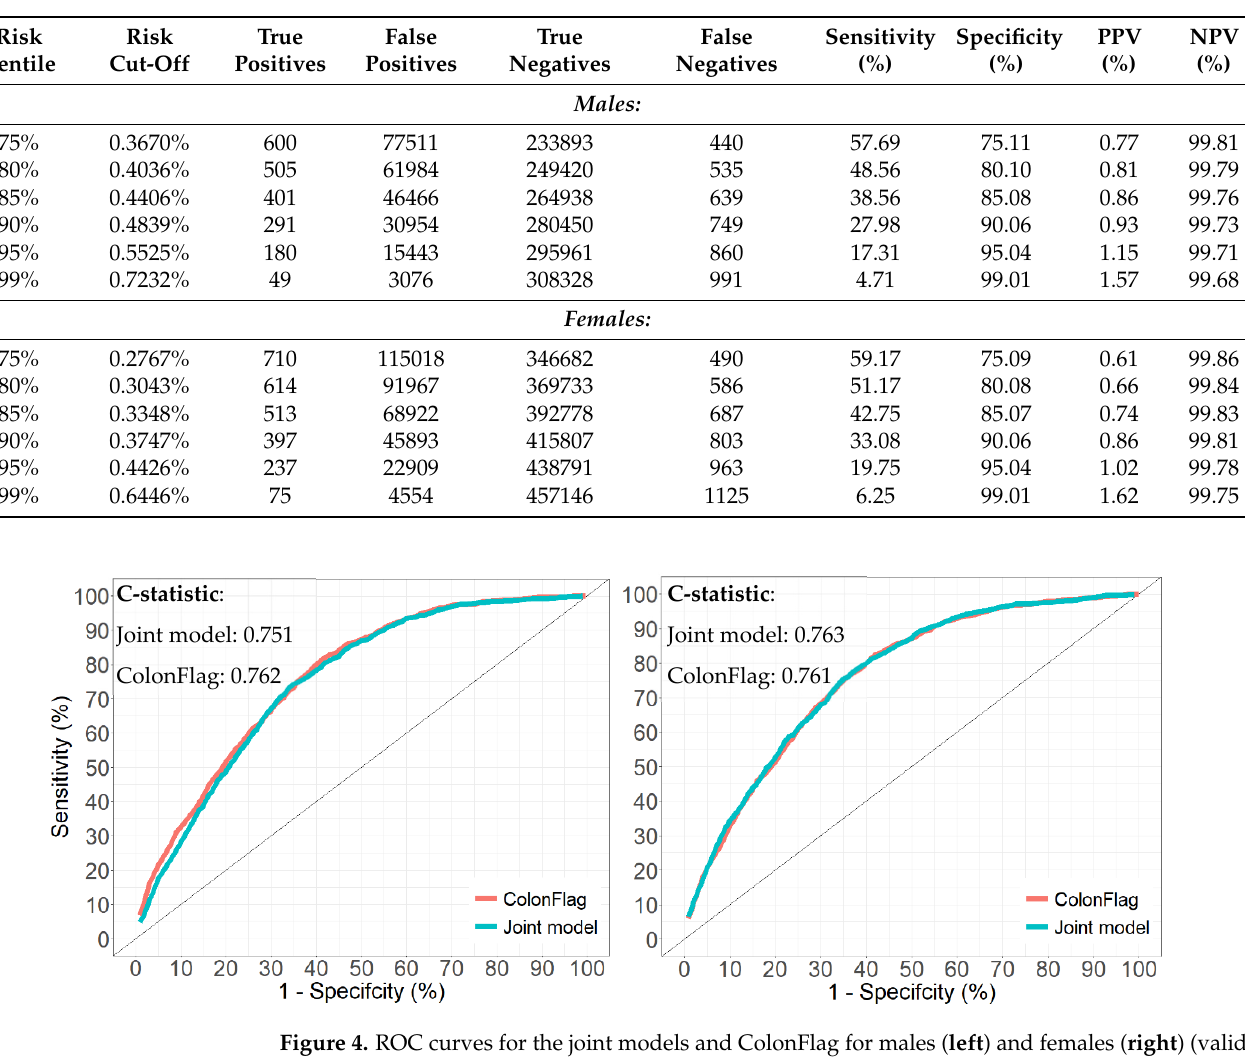
Table 4. Diagnostic accuracy measures of the joint models (validation cohort).